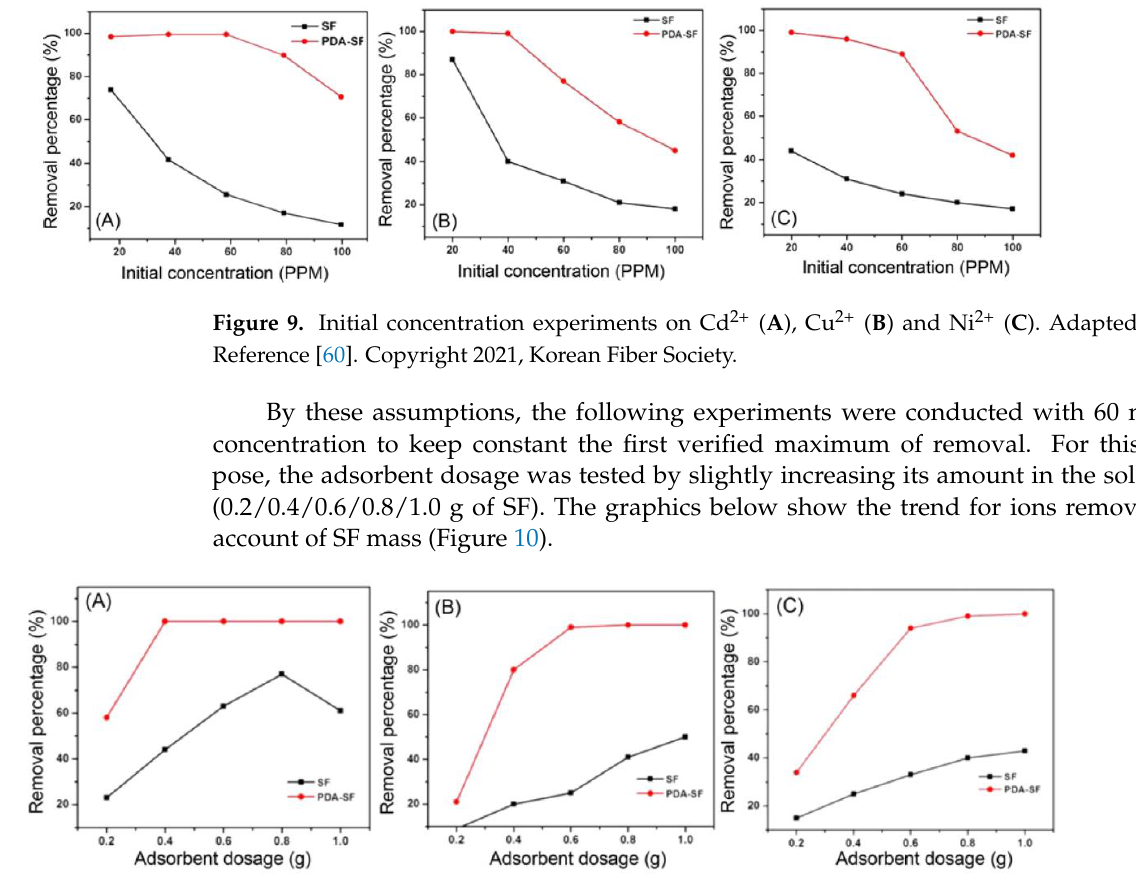
Figure 10. SF amount experiments on Cd 2+ ( A ), Cu 2+ ( B ) and Ni 2+ ( C ). Adapted from Reference [60]. Copyright 2021, Korean Fiber Society.